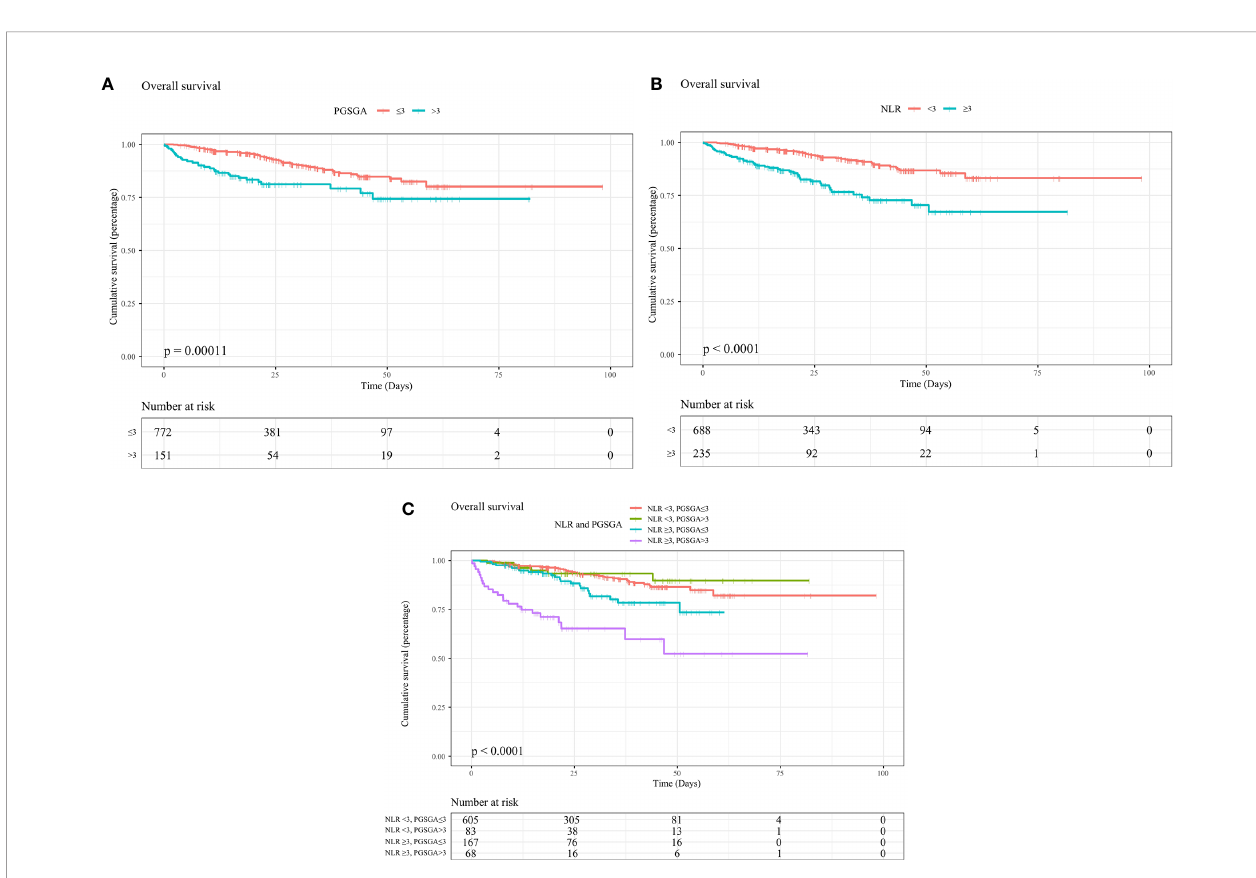
FIGURE 2 | Kaplan – Meier curves show survival rates for patients with NPC undergoing chemoradiotherapy with (A) PG-SGA (PG-SGA score >3, ≤ 3), with (B) NLR (NLR ≥ 3, < 3), with (C) NLR and PG-SGA (high PG-SGA and high NLR group, high PG-SGA and low NLR group, low PG-SGA and high NLR group, and low PG- SGA and low NLR group). NPC, nasopharyngeal carcinoma; PG-SGA, Patient-Generated Subjective Global Assessment; NLR, neutrophil-to-lymphocyte ratio.